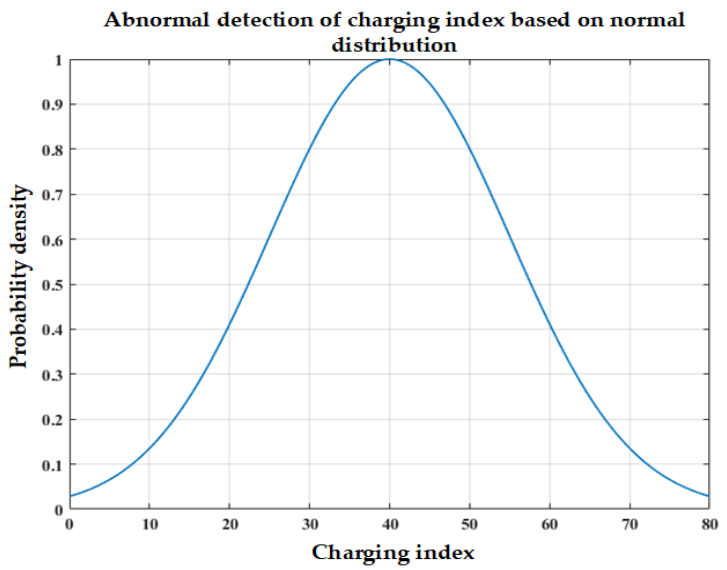
Figure 15. Anomaly detection of charging indicators based on normal distribution.